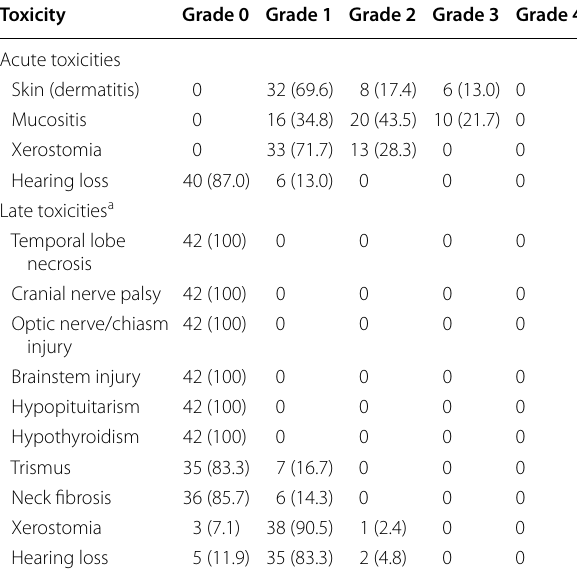
Table 4 Acute and late toxicities in the 46 NPC patients treated with 50 Gy radiotherapy plus hematoporphyrin